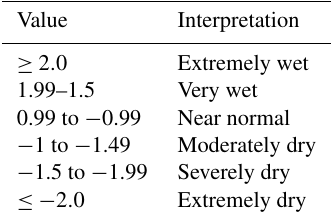
Table 1. Interpretation of SPI values (McKee et al.,